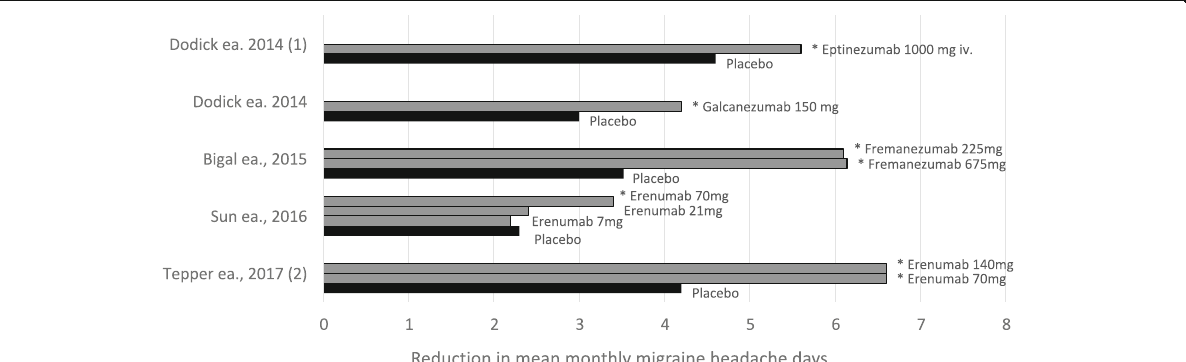
Fig. 2 Efficacy of monoclonal antibodies in the preventive treatment of migraine. Bars indicated with * represents statistically significant values compared to placebo ( p < 0.05). (1) had change in mean monthly migraine days from baseline to weeks 5 – 8 as the primary endpoint. All other studies had change in monthly migraine days from baseline to weeks 9 – 12 of the 12-week double-blind treatment phase as the primary endpoint. In (1) the drug/placebo was administered intravenously. In all other studies, the drug/placebo were given subcutaneously. (2) is on chronic migraine patients. All other studies are on episodic migraine